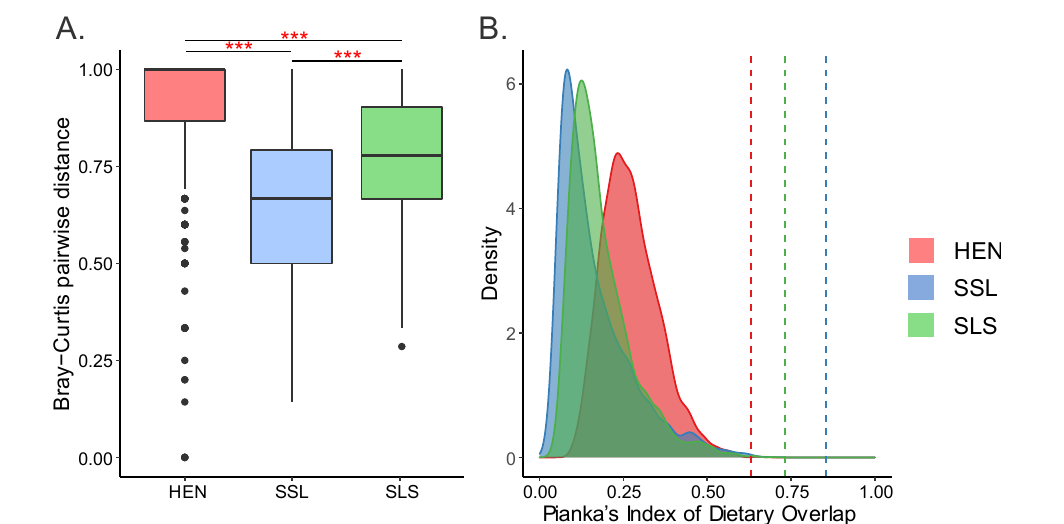
Figure 5. Diet overlap between Zingel asper and Cottus gobio. ( A ) Bray – Curtis pairwise distances between Z. asper and C. gobio diets by sampling campaign (non-parametric Dunn tests: *** = p < 0.001). ( B ) Pianka’s index of dietary overlap of Zingel asper and Cottus gobio diets. Density plot indicates null model-simulated Pianka values, dashed lines indicate observed Pianka values.